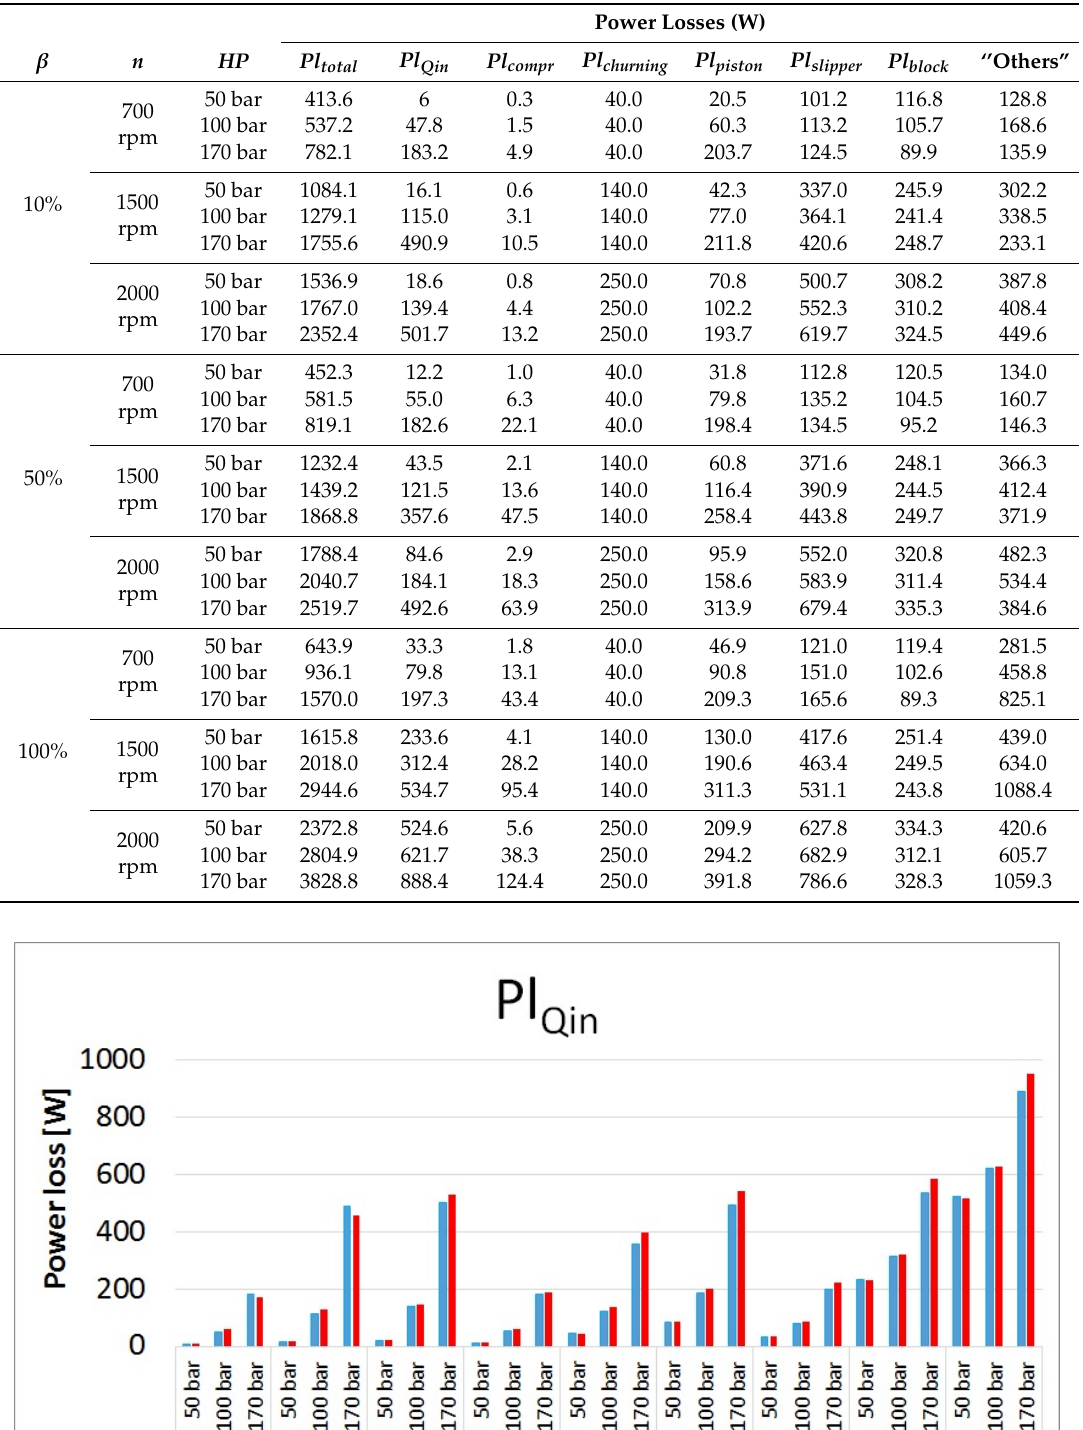
Table 5. Distribution of power losses in the S-APP a 52 cc size; θ B = 50 ◦ C. Power Losses (W)